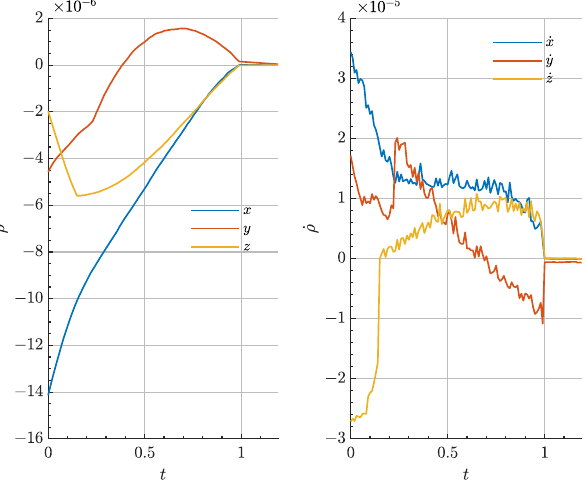
Figure 22. Relative state evolution for the Lunar Gateway resupply mission during the close- range rendezvous.